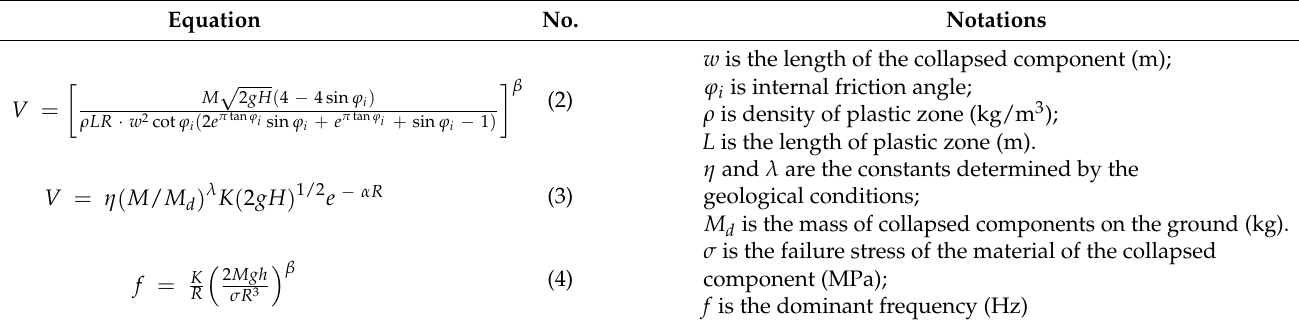
Table 1. The list of empirical